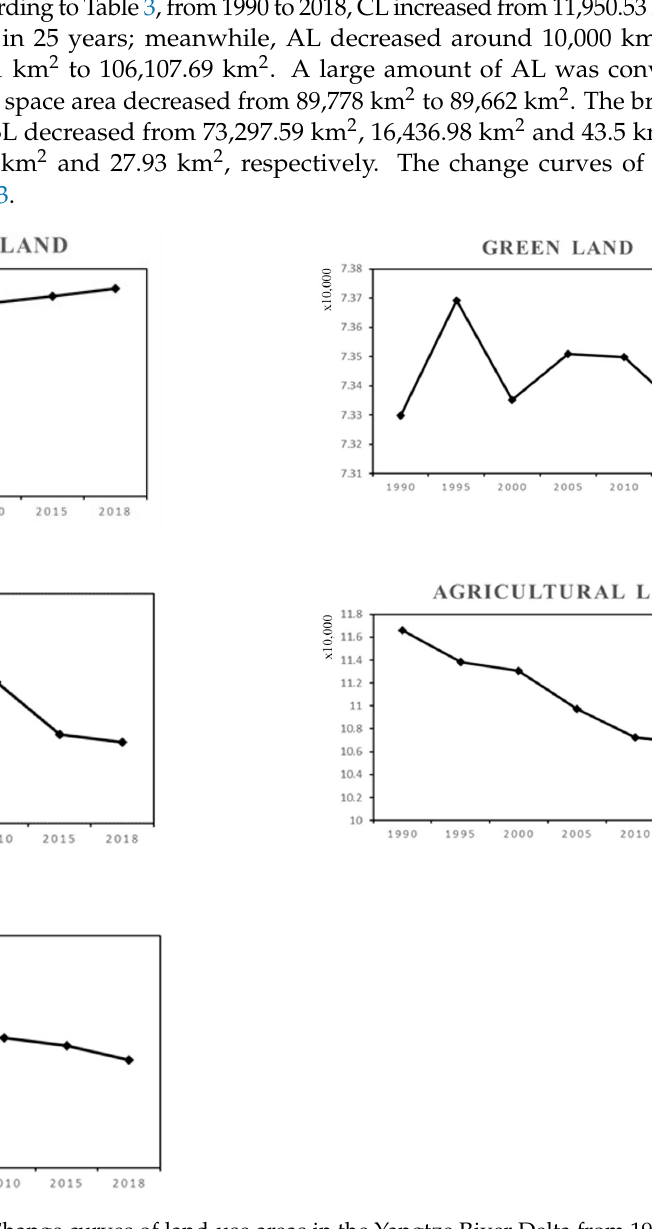
Figure 3. Change curves of land-use areas in the Yangtze River Delta from 1990 to 2018. The LUC data of different provinces are listed in Table 4. The data change is visualized in Figure 4. Table 4. LUC data of different provinces in the Yangtze River Delta Urban Agglomeration (Unit: km 2 ).